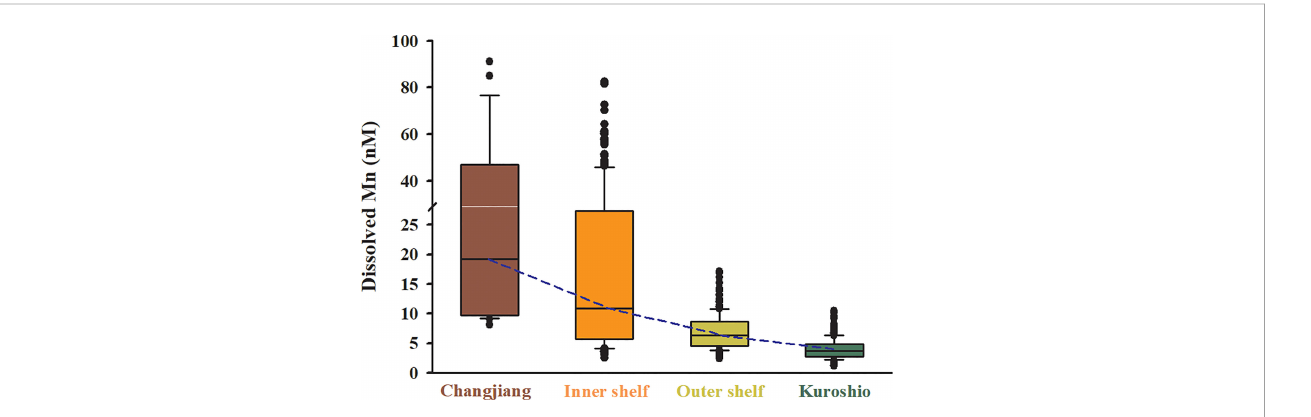
FIGURE 8 Dissolved Mn concentration distribution throughout the East China Sea. All samples were divided into four groups: the Changjiang plume, Inner shelf, Outer shelf, and Kuroshio